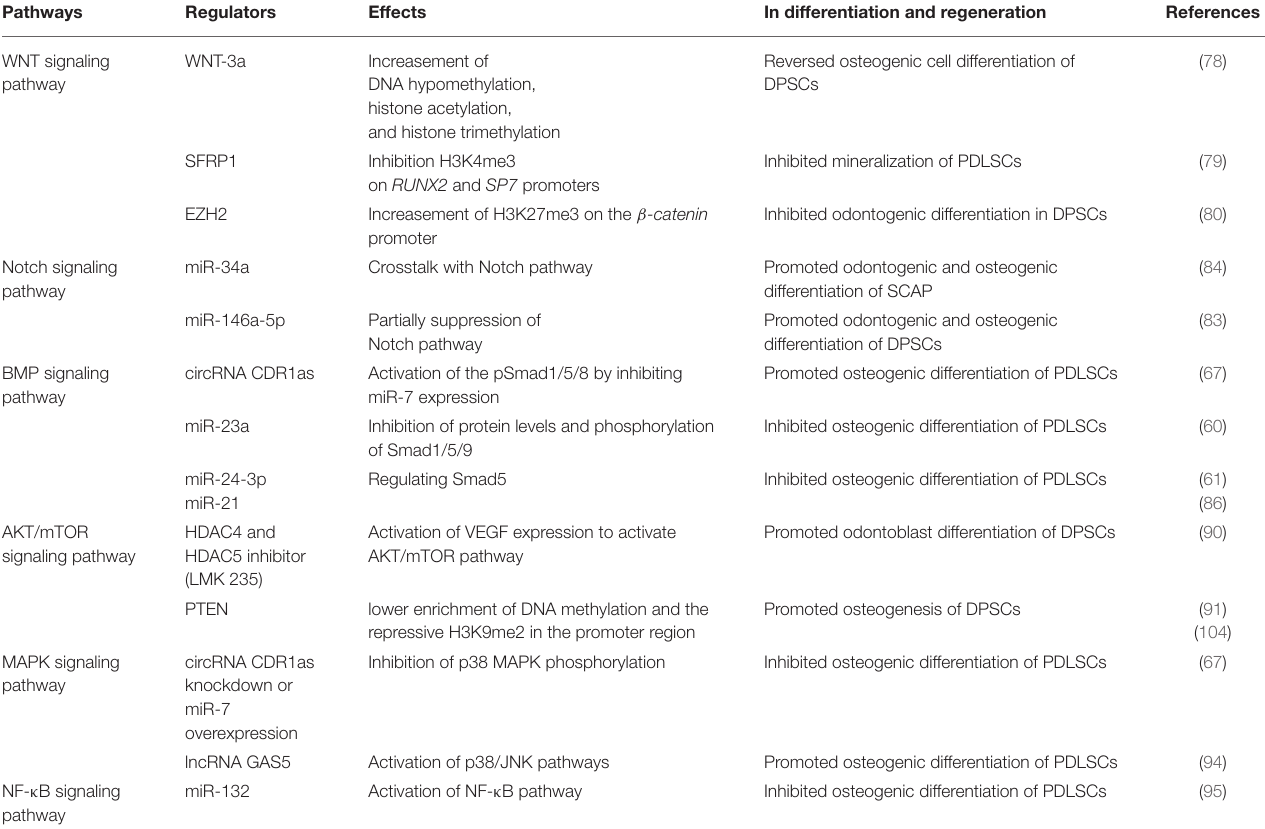
TABLE 2 | Key pathways regulated by epigenetic